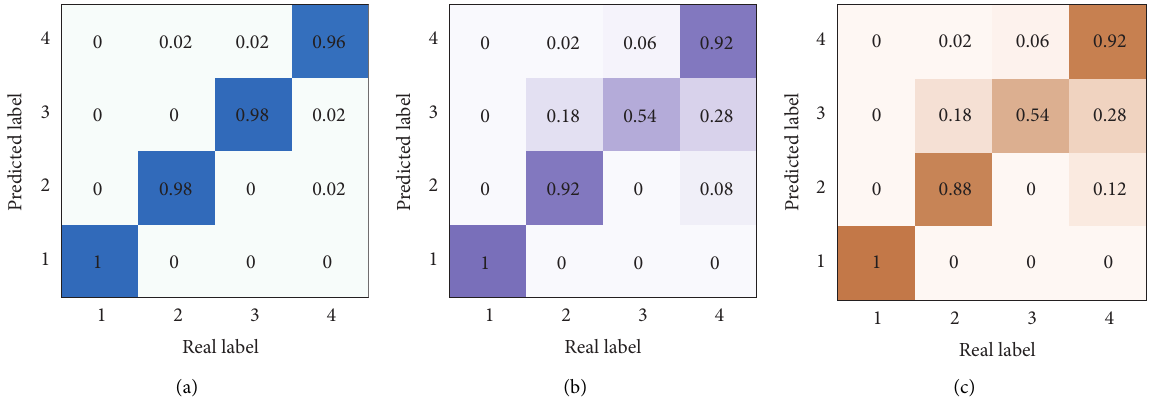
Figure 10: Clustering accuracy of MFS-MG data sets. (a) ATDPS; (b) K-means; (c)